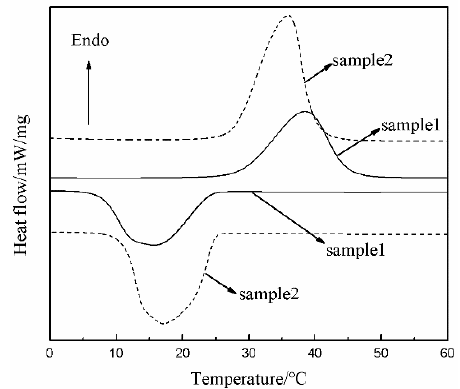
Figure 9. DSC curves of sample 1 and sample 2: Sample 1 was the MPF; sample 2 was the microPCM function layer with a coating thickness of 1.5 mm.